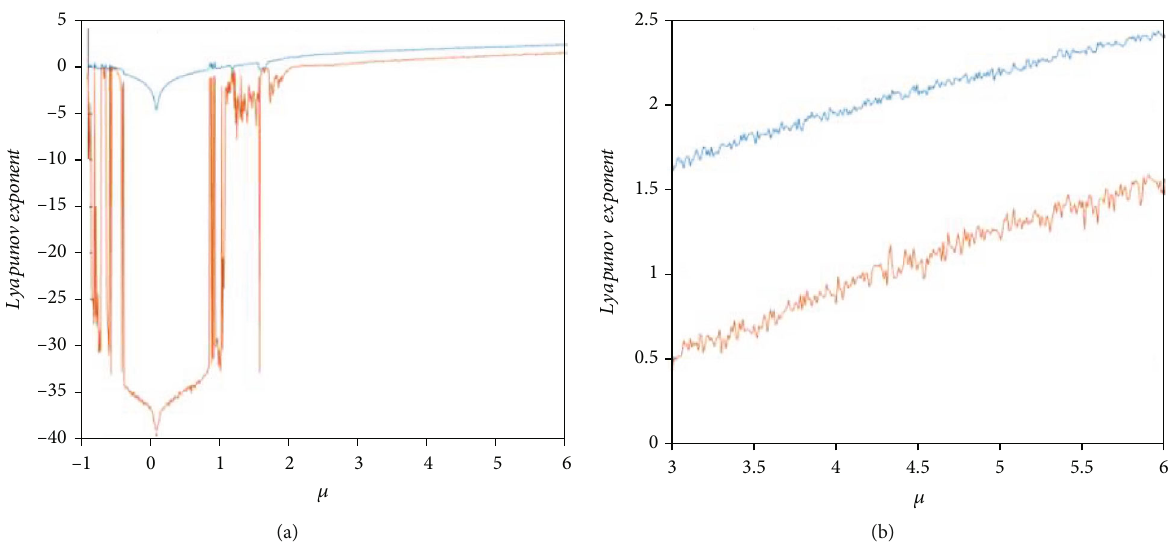
Figure 2: Lyapunov exponent of 2D-SCH. (a) Lyapunov exponent of μ ∈ ½ − 1, 6 (cid:2) . (b) Lyapunov exponent of μ ∈ ½ 3, 6 (cid:2) .